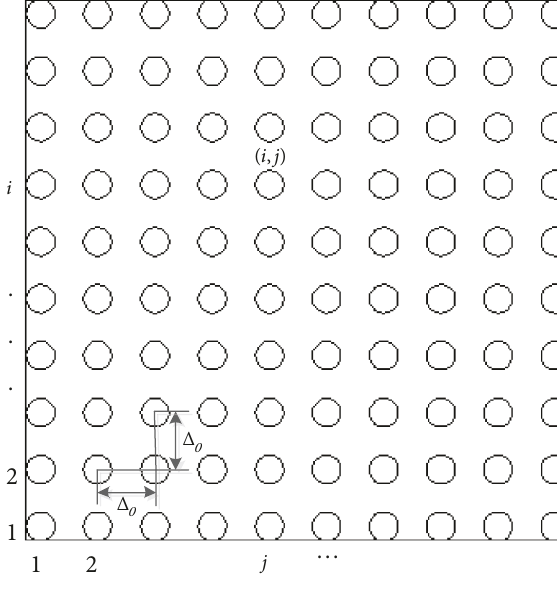
Figure 2: Front view of